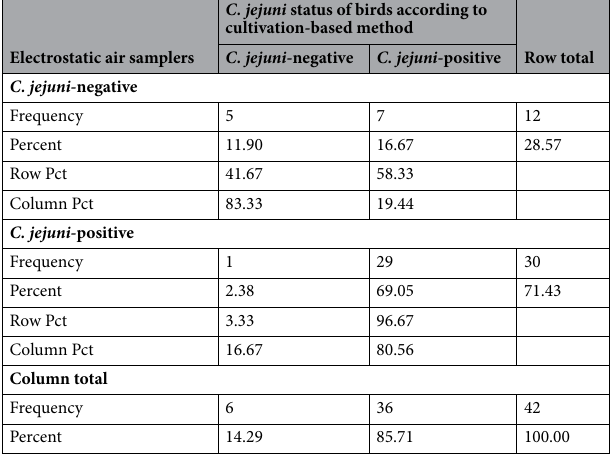
Table 4. McNemar test and kappa statistics evaluating electrostatic air samplers above the area where C. jejuni‑ infected birds were kept with increasing and decreasing animal numbers. Pct Percent, p -value of McNemar’s test: 0.0703; kappa value: